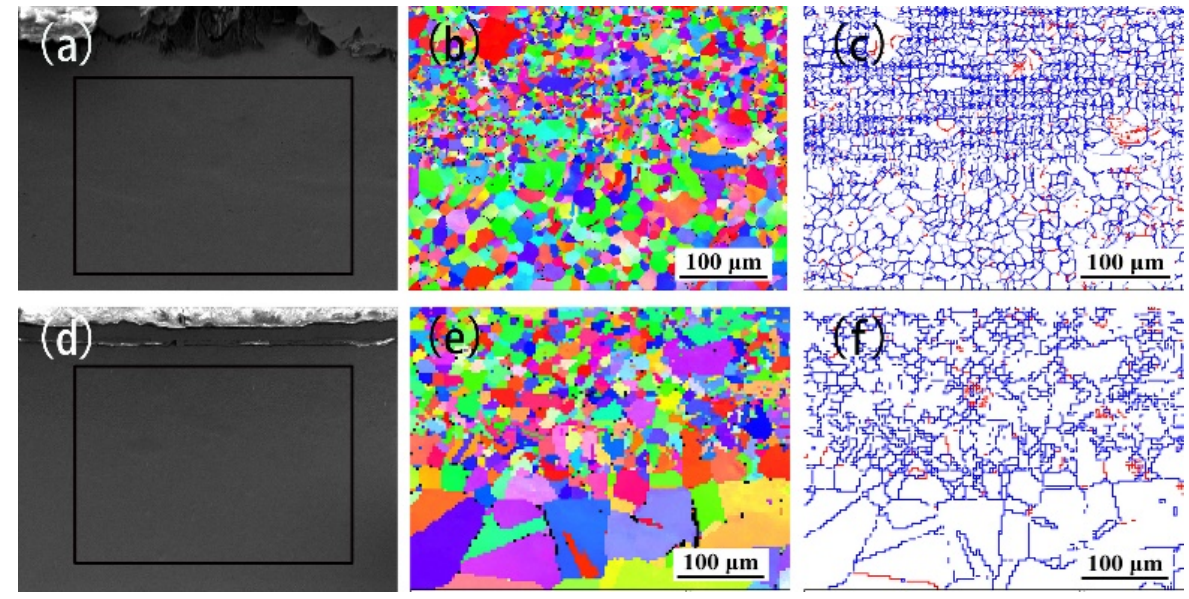
Figure 3. Grain orientation and grain boundaries obtained from EBSD analysis of a cross-section of CuAlxNiCrFe HEA coatings and a nickel-based superalloy substrate before and after 100 h of oxidation at 1100 °C. ( a – c ) CuAlxNiCrFe HEA coatings, ( d – f ) Nickel-based superalloy substrate (Reprinted with permission from ref. [40]. Copyright 2021 Elsevier).